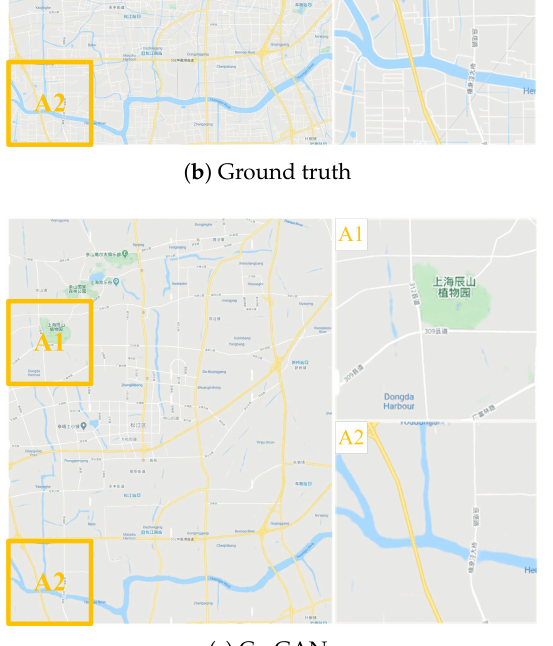
Figure 13. The generation results with level 14 via the proposed CscGAN in Songjiang District of Shanghai. For clarity, the zoomed local areas (A1 and A2) are on the right of the